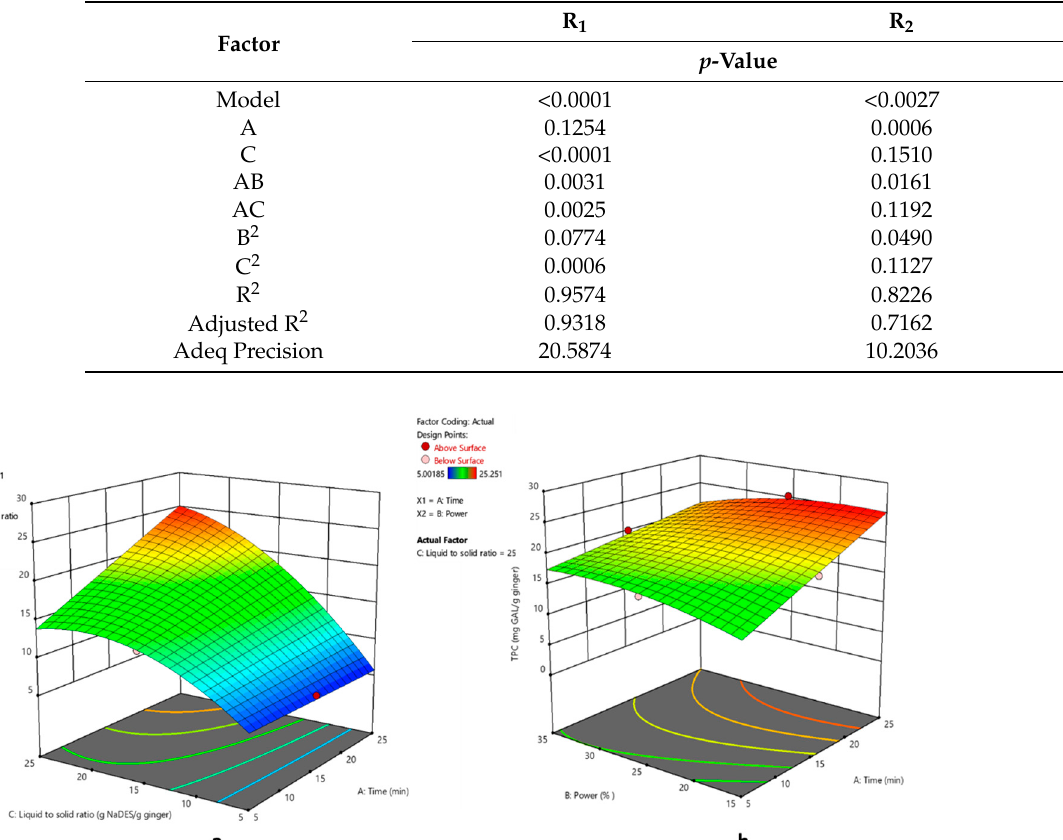
Table 4. Significance of each factor equation model terms for the responses R 1 (TPC) and R 2 (antioxi-